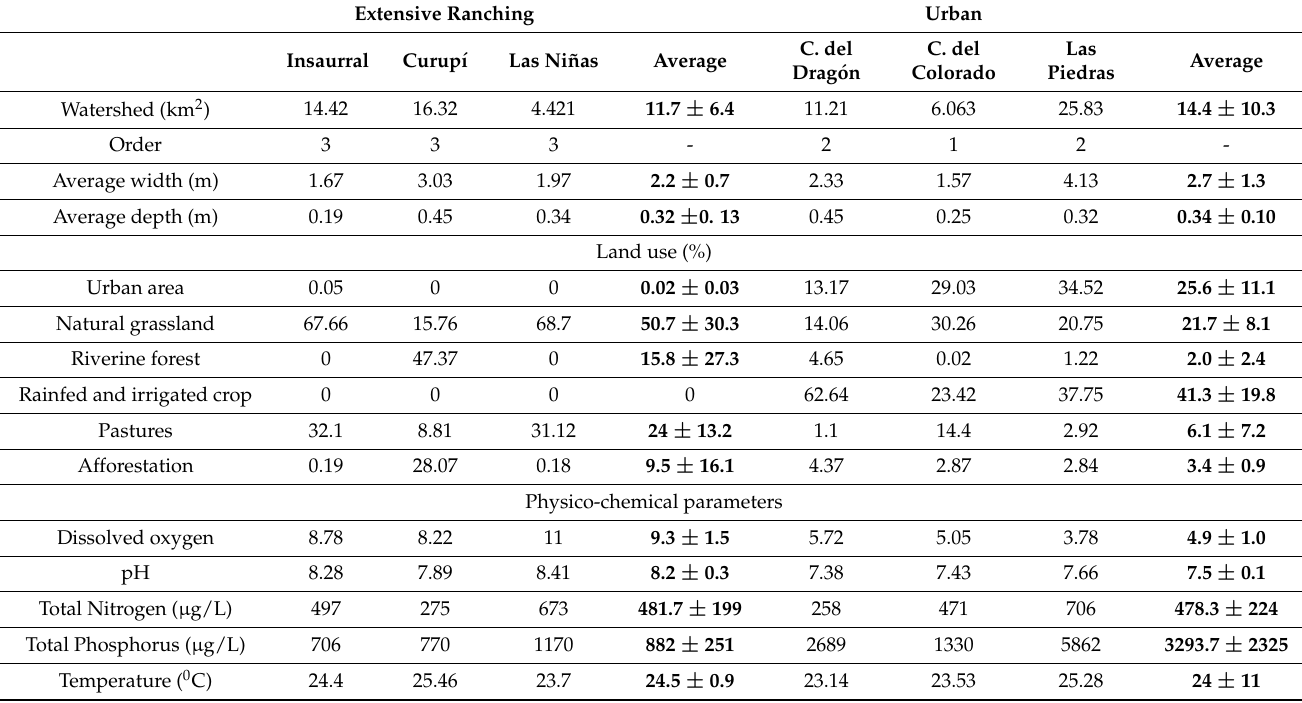
Table 1. Main characteristics of the 6 streams analyzed, mean and standard deviation per group. The streams are separated in two groups according to the main activity carried out in their watershed: Extensive Ranching (Insaurral, Curup í and Las Niñas) and Urban (Cañada del Drag ó n, Cañada del Colorado and Las Piedras). Extensive